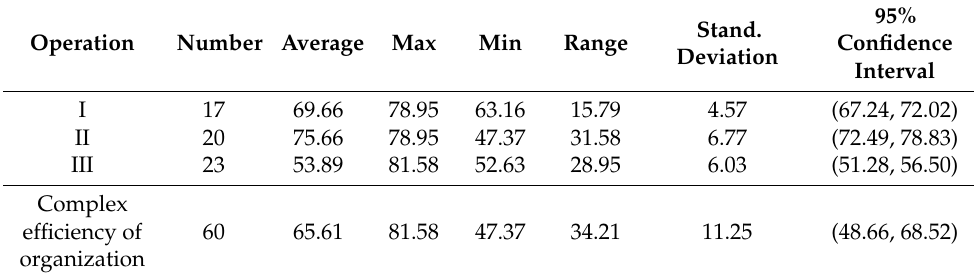
Table 4. Descriptive statistics of the total efficiency of measures ∆ in operations [%].